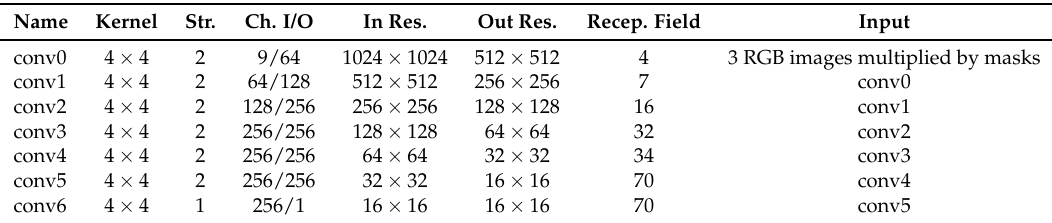
Table 3. The PatchGAN discriminator architecture and receptive fields for different number of layers